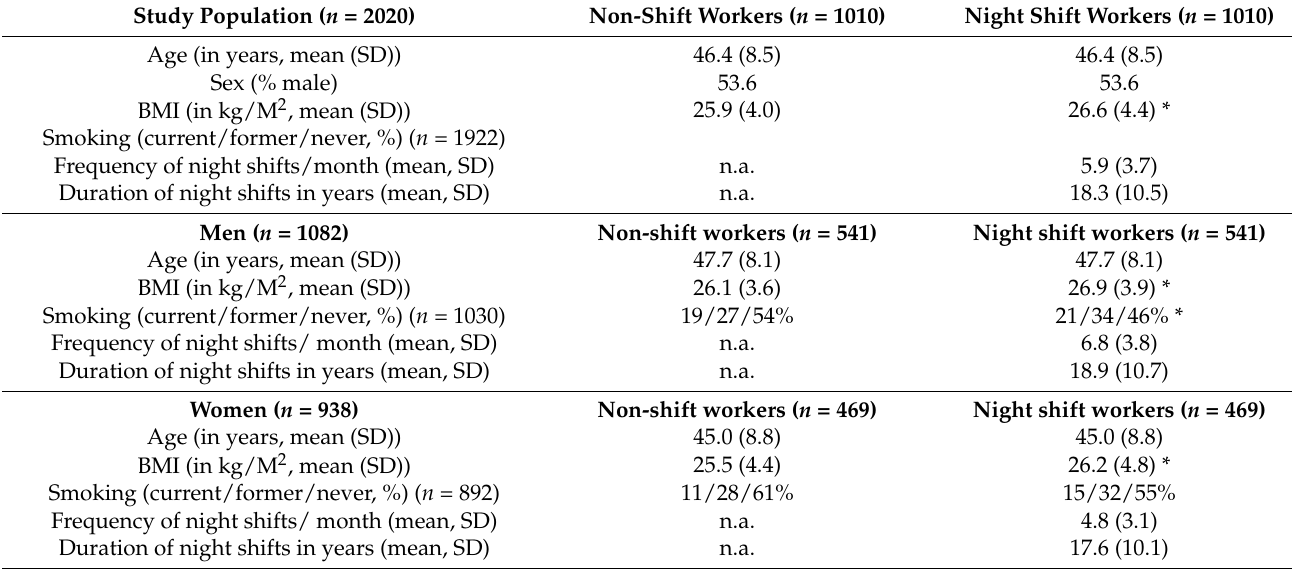
Table 1. Characteristics of the study